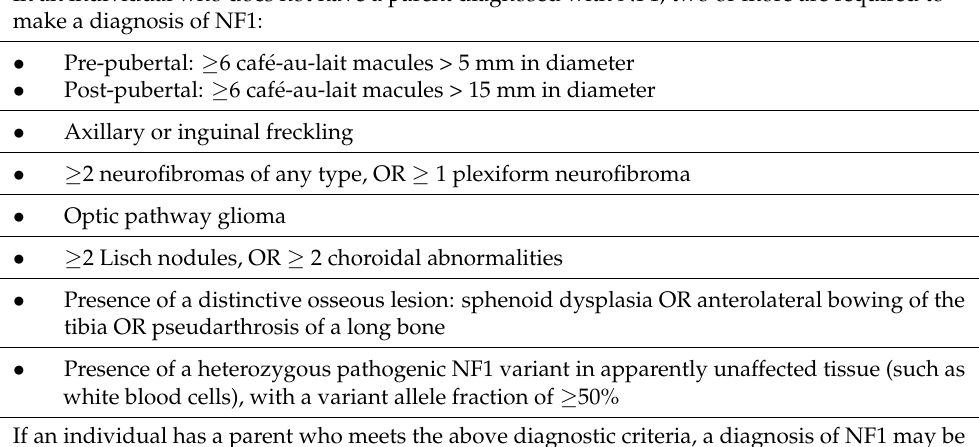
Table 1. National Institutes of Health diagnostic criteria for neurofibromatosis type 1